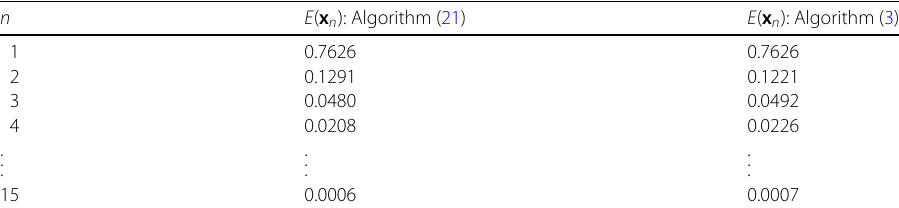
Table 2 Detailed analysis of computational methods (21) and (3) for Example 1 with u = 3 t , N = 15 and E ( x n ) = (cid:4) x n +1 – x n (cid:4) , n ∈ N